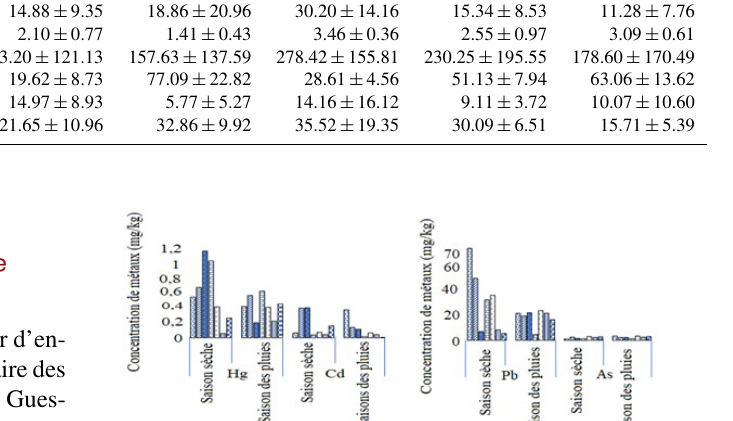
Tableau 1. Teneur moyenne des éléments traces et valeurs Préindustrielles. Métaux Valeurs G1 G2 préindustrielles Hg (µg/g)